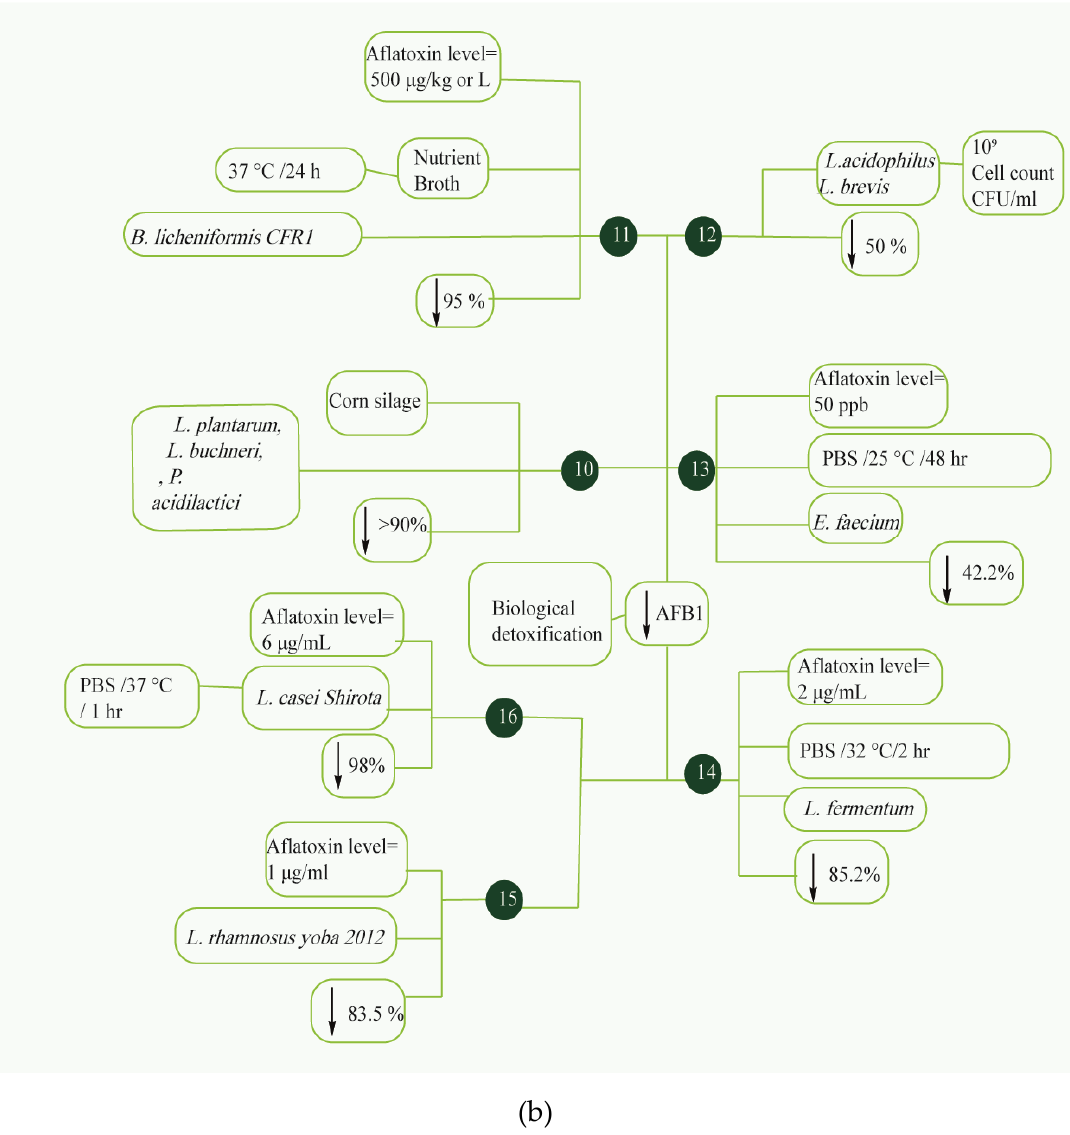
Figure 5. Overview of biological detoxification methods. (a): (1, [210]), (2, [211]), (3, [212]), (4, [213]),